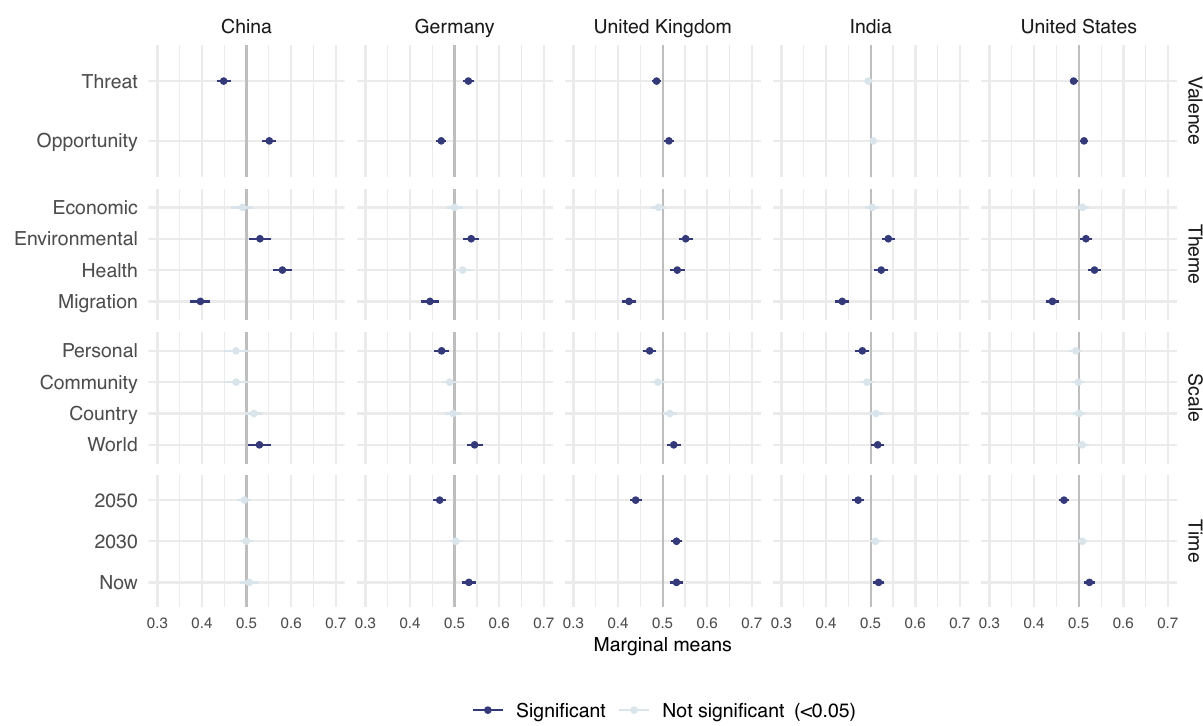
Fig. 1 Effects of different climate frames on respondents ’ support for climate policies. Sample size: China n = 1502, Germany n = 1501, United Kingdom n = 1500, India n = 1506, United States n = 1503. Data are weighted to be nationally representative. Fieldwork by Deltapoll, October 2020. Question: Respondents were shown two statements in which the valence, theme, scale, and time frame were varied at random, providing 96 possible permutations. Respondents were asked: Indicate which of the two statements would make you more likely to support policies to tackle climate change. Dots with horizontal lines indicate marginal means with 95% con fi dence intervals